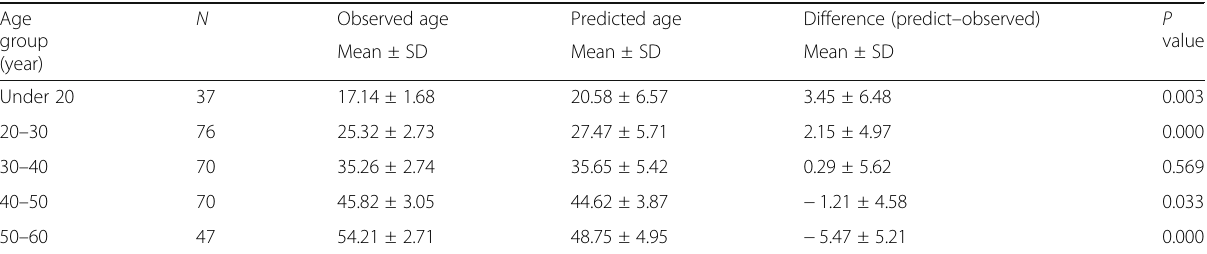
Table 4 Comparison of the actual and estimated age by the regression model including significant variables ( n = 300) Age